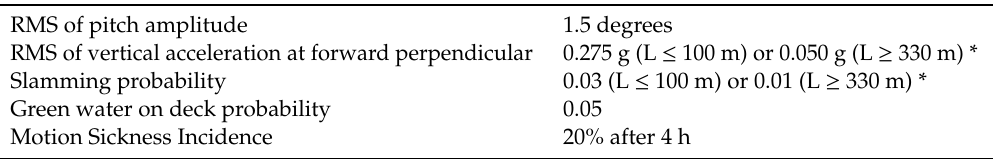
Table 1. General operability limiting criteria for